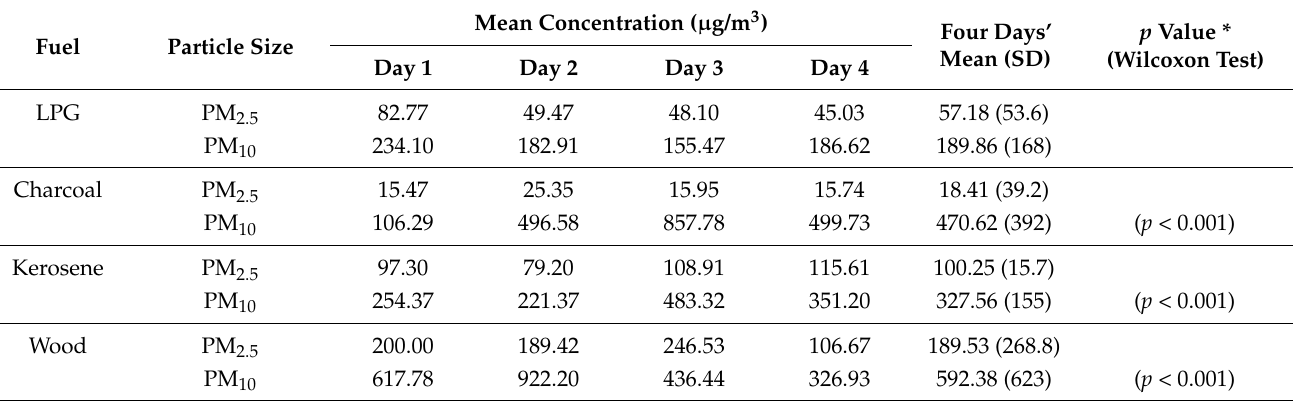
Table 2. Comparison of mean PM concentrations by fuel